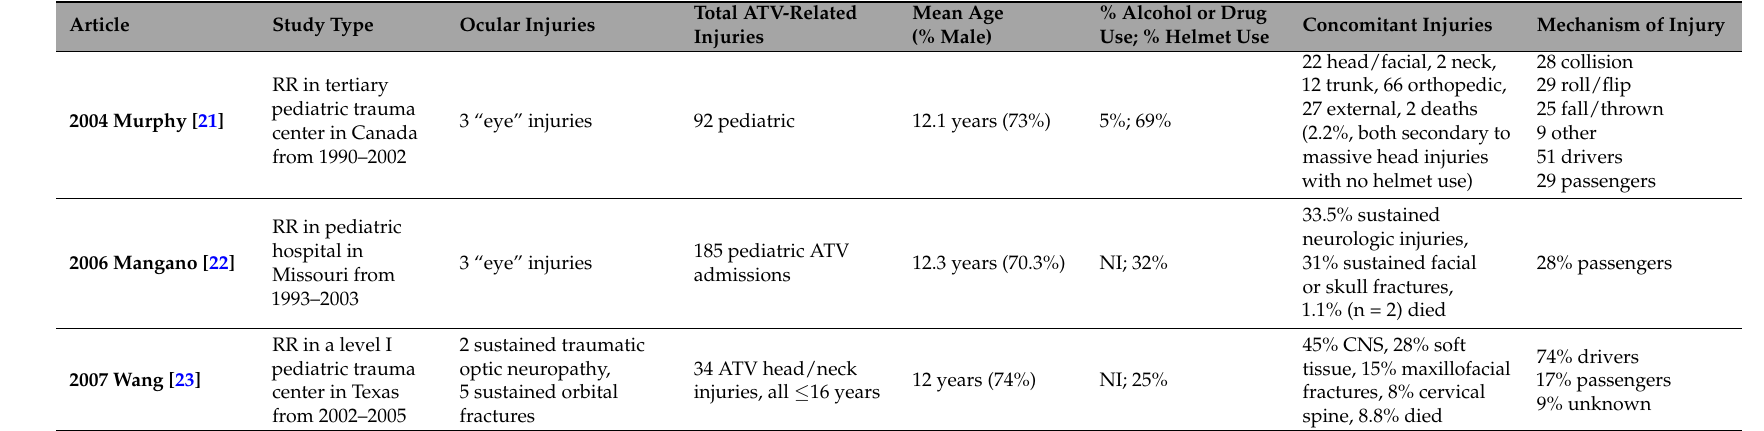
Table 3. Pediatric ATV-related injuries with brief mention of ocular involvement. Use of ocular protection was not recorded for any study. ATV: all-terrain vehicle. RR: retrospective review. NI: no